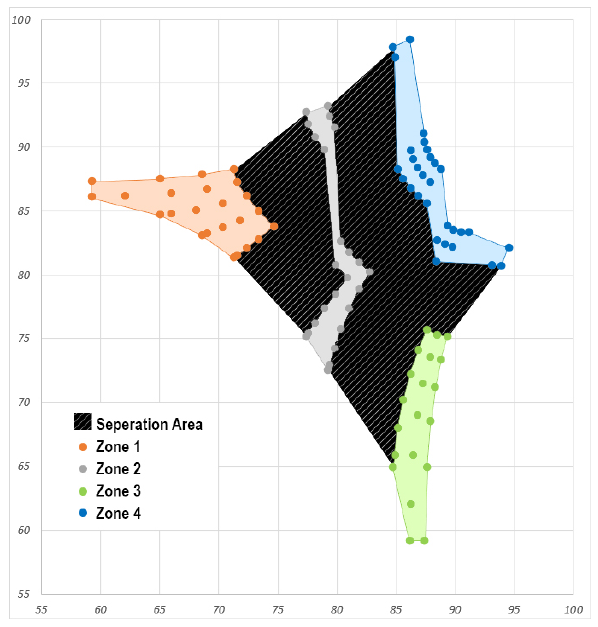
Figure 3. Class separation areas